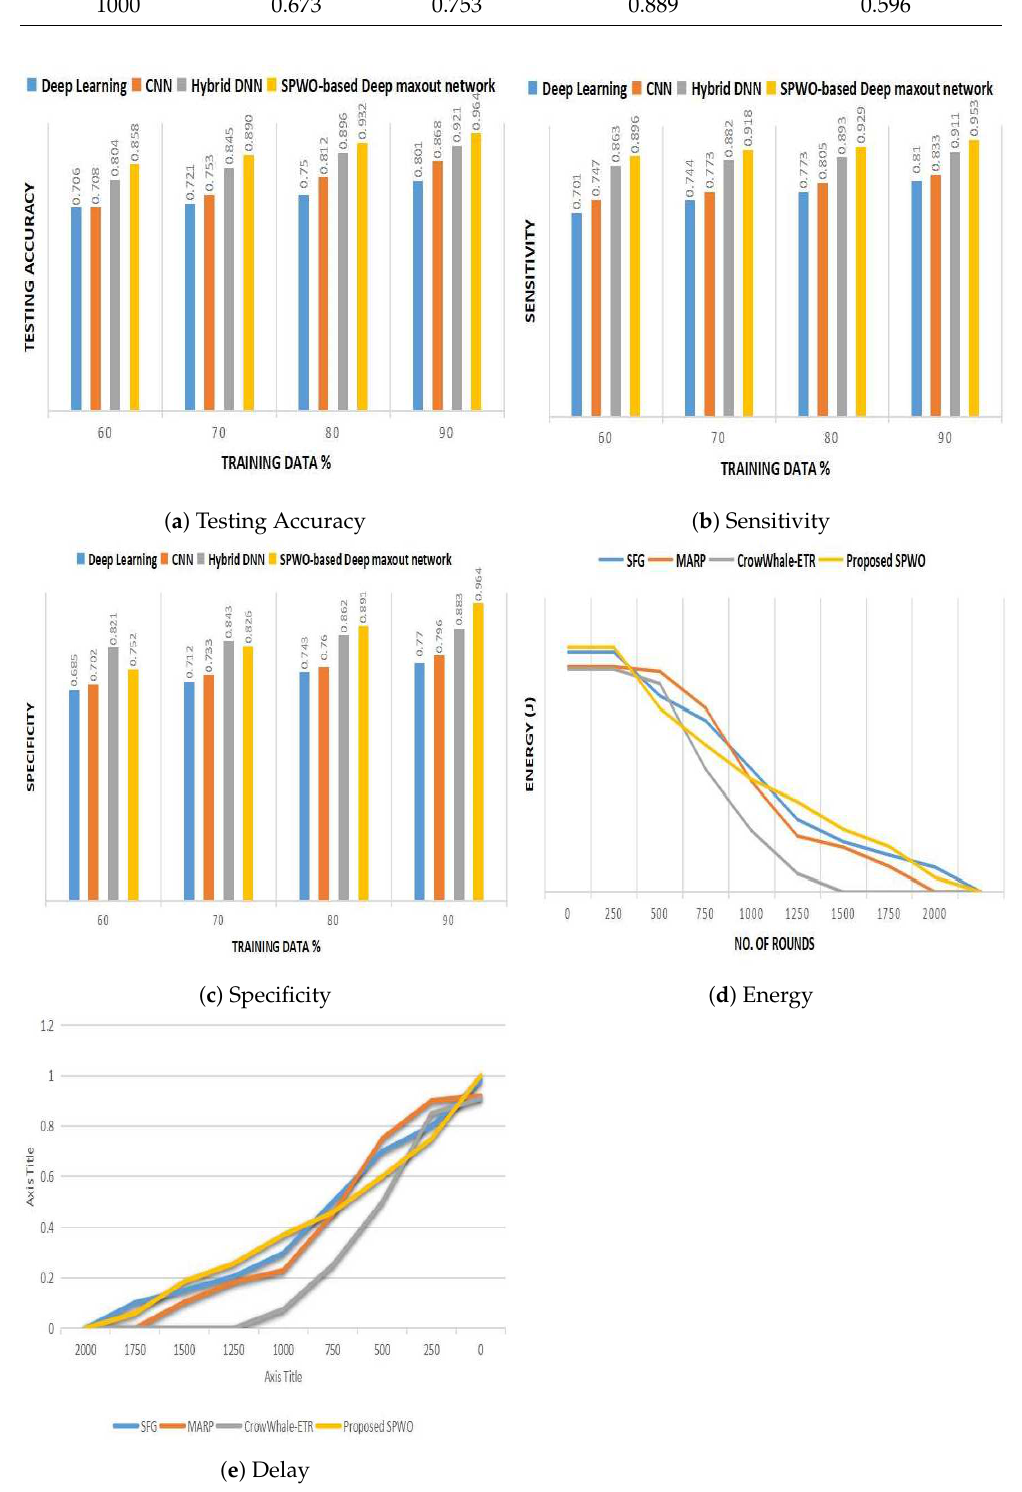
Figure 5. Analysis using 100